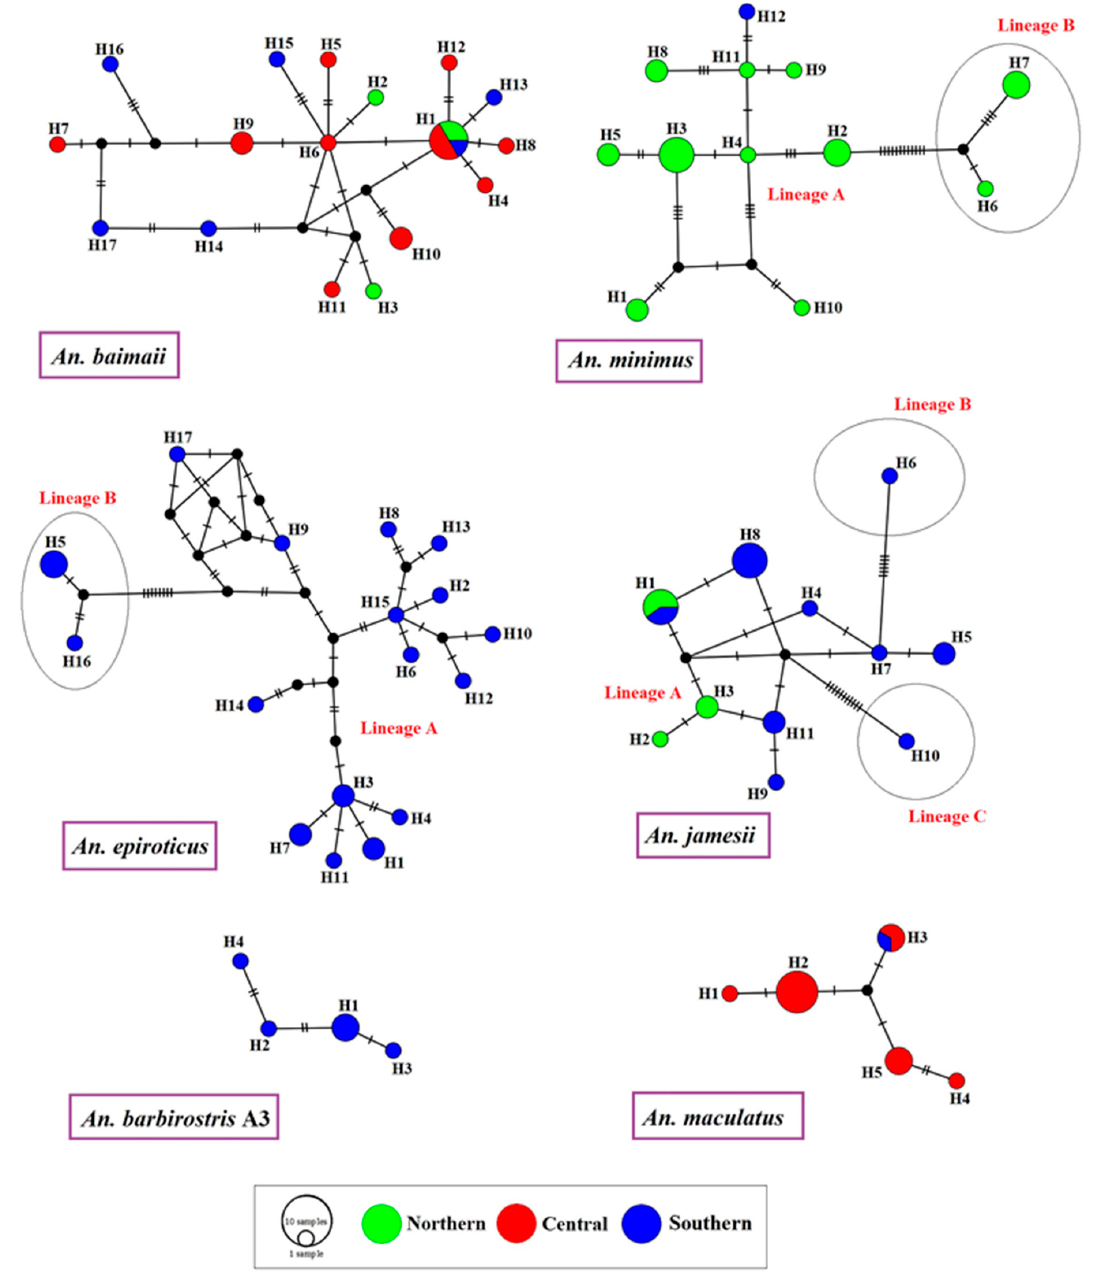
Figure 3. COI haplotype networks of Anopheles specimens collected from three locations in Ranong province, Southern Thailand. Anopheles species represented by only one specimen, including An. aconitus and An. sawadwongporni , were excluded from the analyses. A colored circle represents each haplotype, and the circle’s size is proportional to the total sequence of each haplotype. The number of mutations is shown by the dashes along the haplotype lines; the different colored circles represent different locations in Thailand.